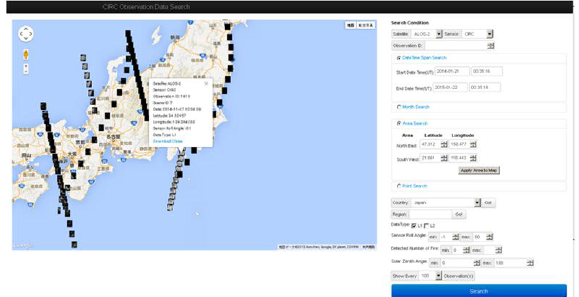
Figure 18. Example of CIRC observation data